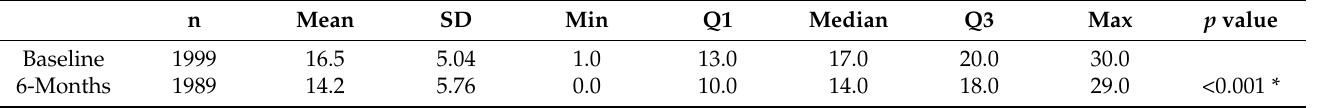
Table 4. sNLQ count scores from baseline to 6-months